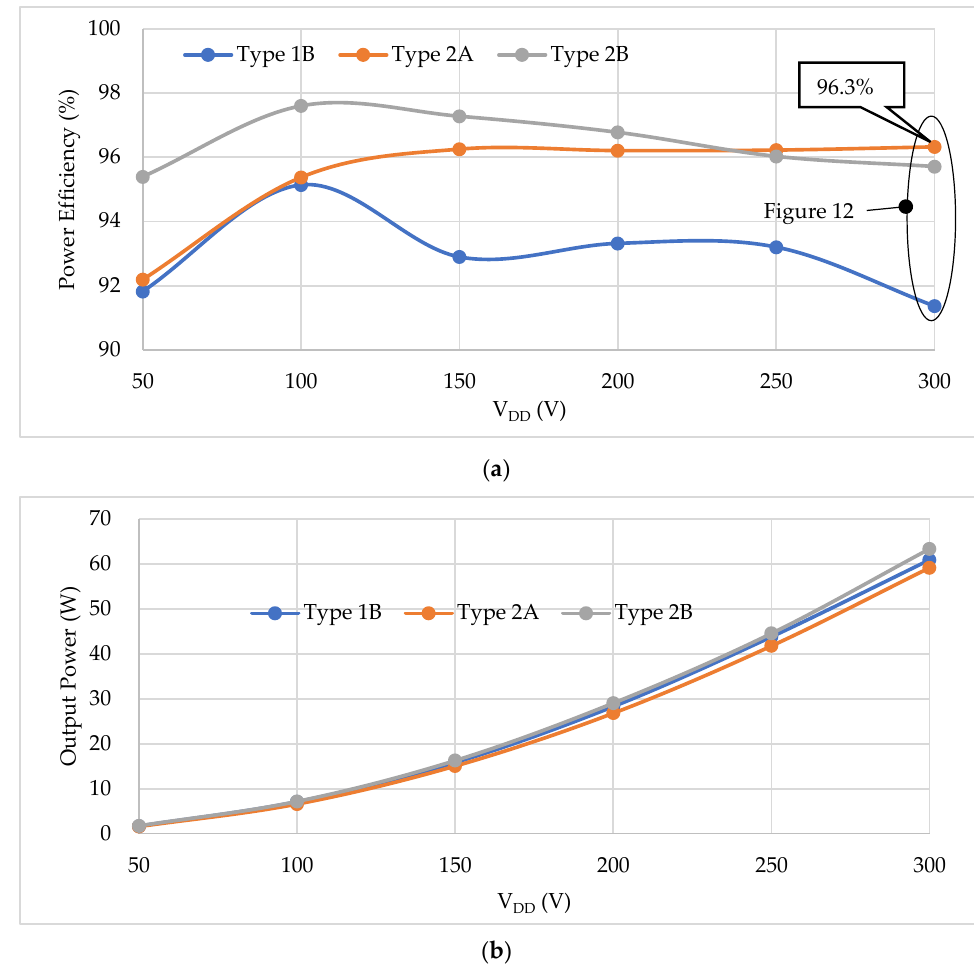
Figure 14. DCM response comparison under the same switching frequency and duty. ( a ) power efficiency vs. V DD ; ( b ) output power vs. V DD .